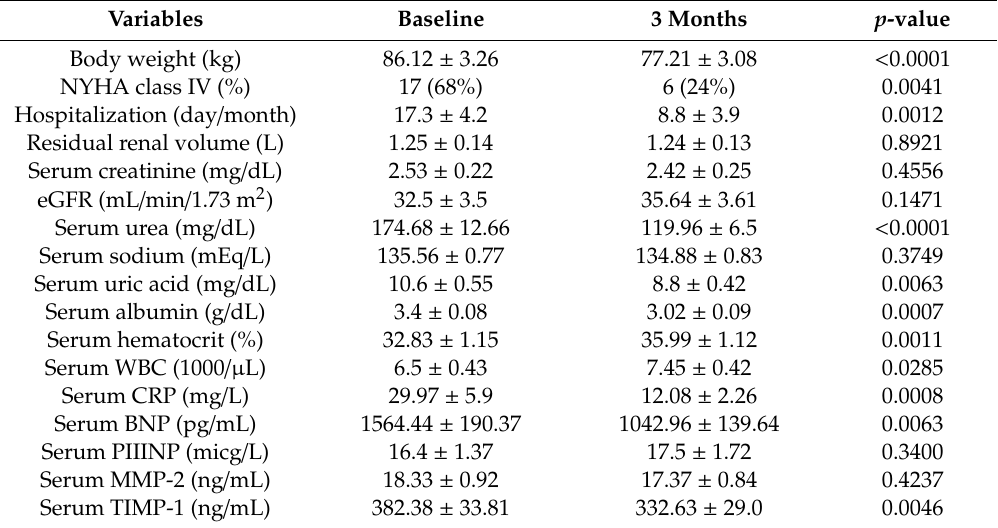
Table 2. Selected clinical and biochemical characteristics after 3 months of PD treatment ( n =